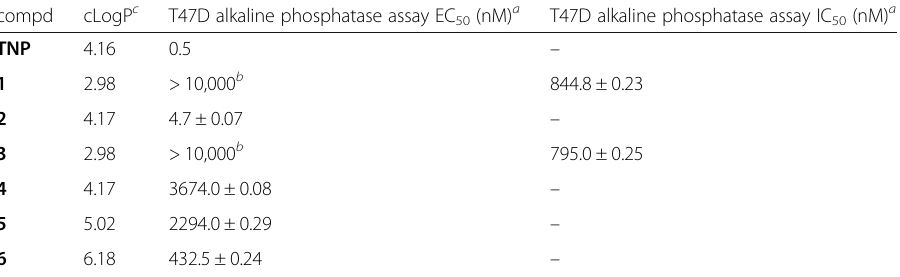
Table 1 Potency of 1 – 6 in a T47D alkaline phosphatase assays, including Tanaproget (TNP) as a reference